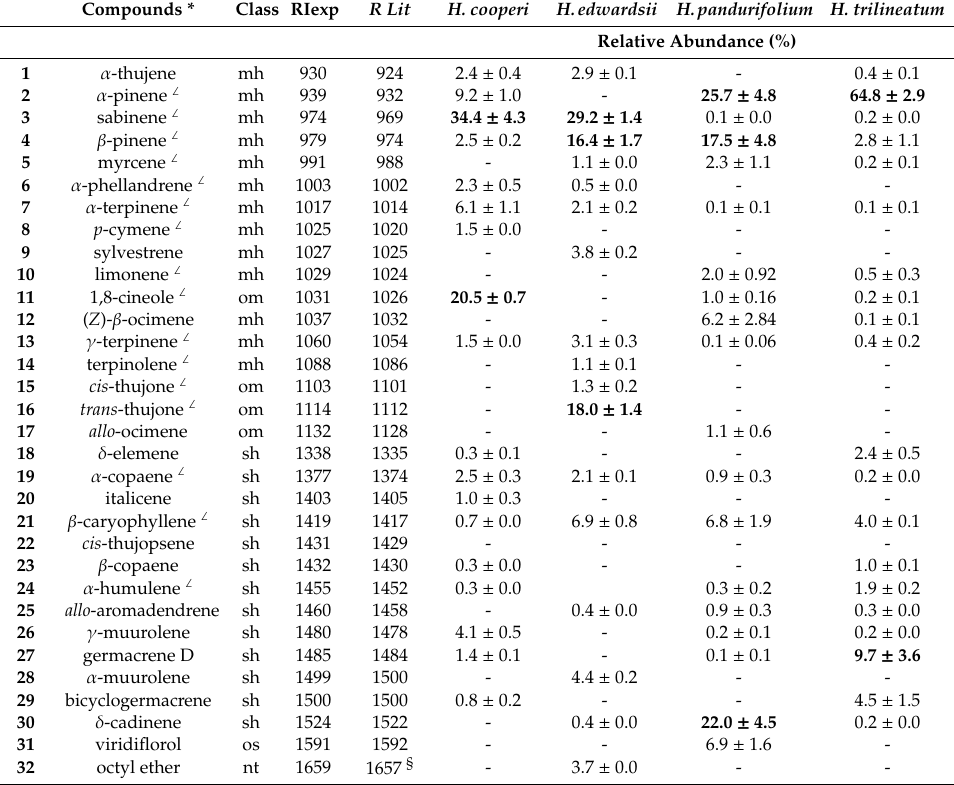
Table 1. Identified compounds in spontaneous emissions of the studied Helichysum spp. (for chromatograms, see Table S1 in Supplementary Materials).